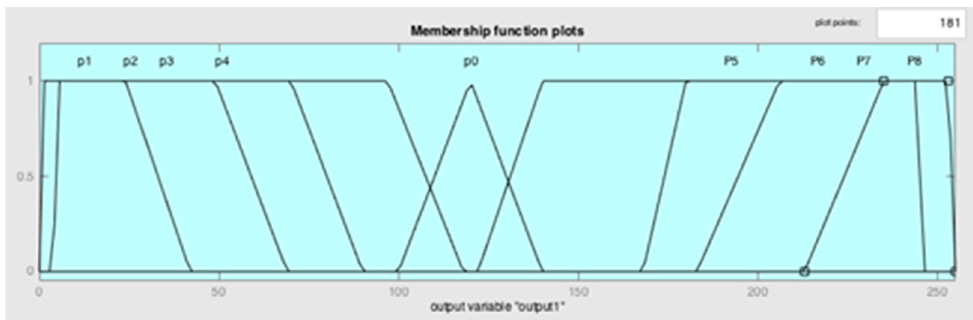
Figure A4. Trapezoidal pH output functions.